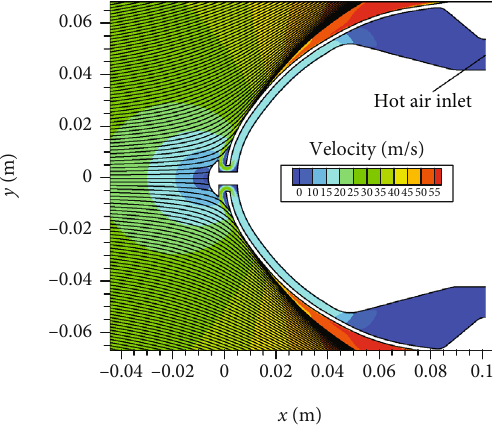
Figure 11: Lagrangian droplet trajectories on the contour of air velocity around the cone section at the droplet diameter of 20 μ m. Figure